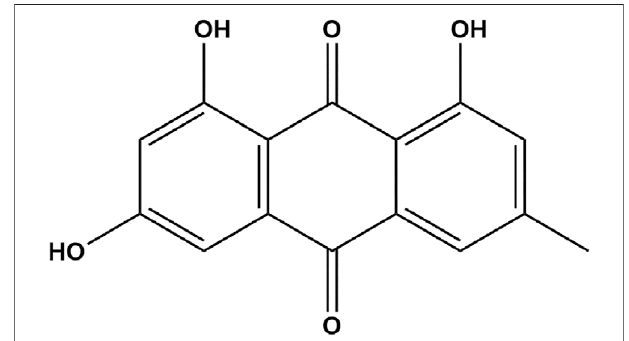
FIGURE 1 | Chemical structure of